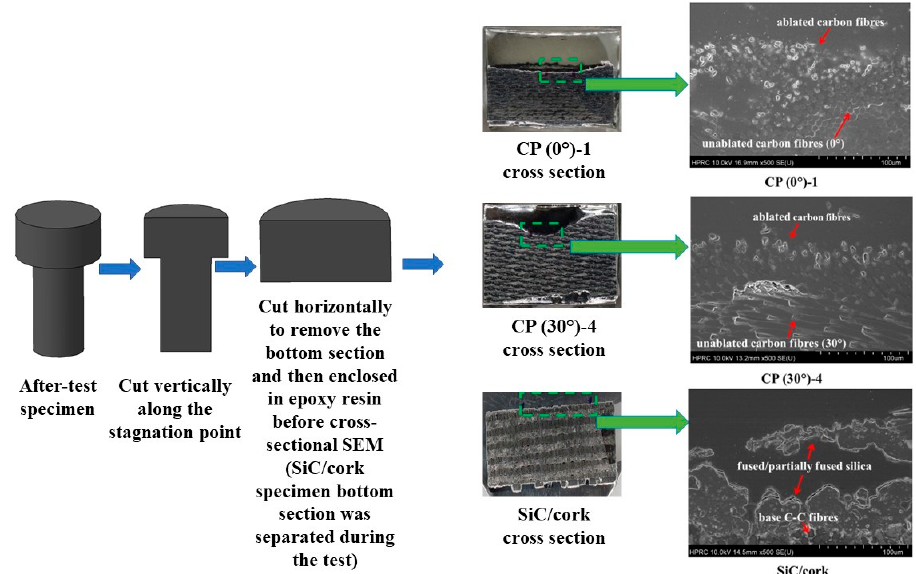
Figure 30. Specimen cross-sectional SEM images (500×).